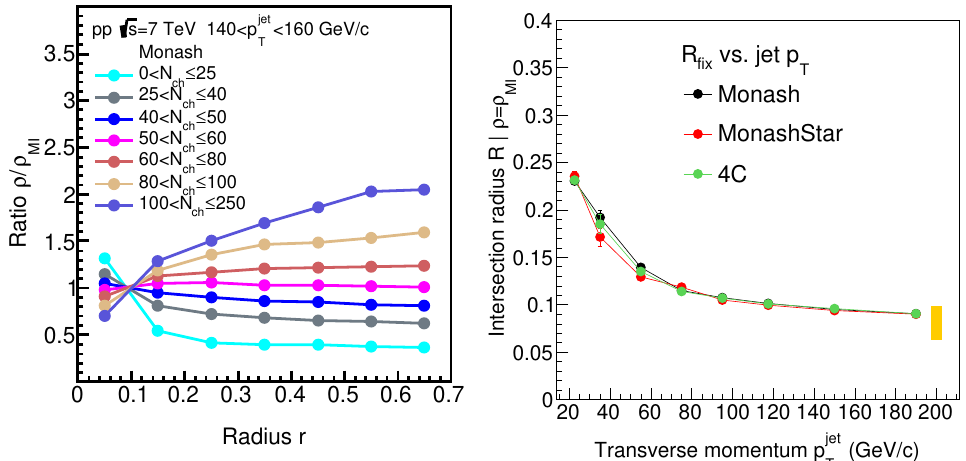
Figure 4. ( Left ) Ratio ρ / ρ MI of the differential jet structure over the multiplicity-integrated curve for many different multiplicity bins; ( Right ) The p jet dependence of R fix with δ r = 0.1. The systematic T uncertainty from the choice of δ r is shown as the yellow band.